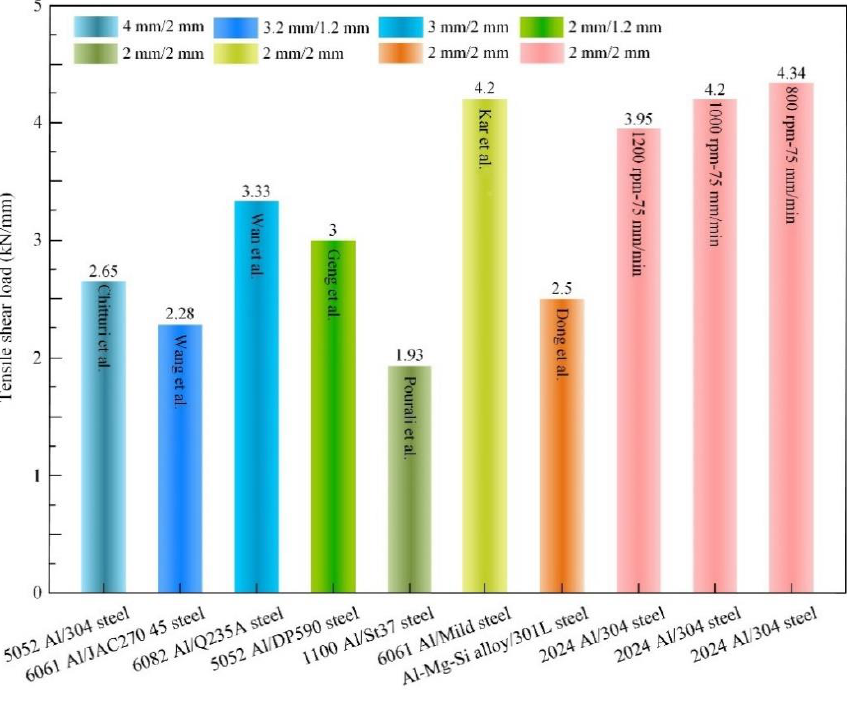
Figure 9. Tensile shear loads of joints of this study and reported literature. Data from